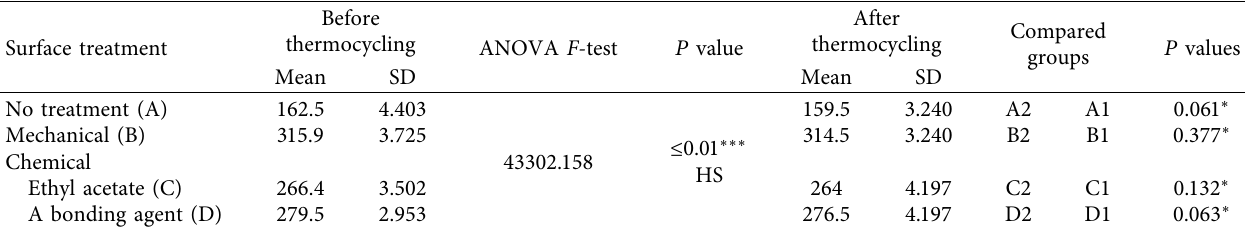
Table 3: Descriptive statistics, one-way ANOVA, and LSD values of the shear bond strength test before and after thermocycling. Surface treatment